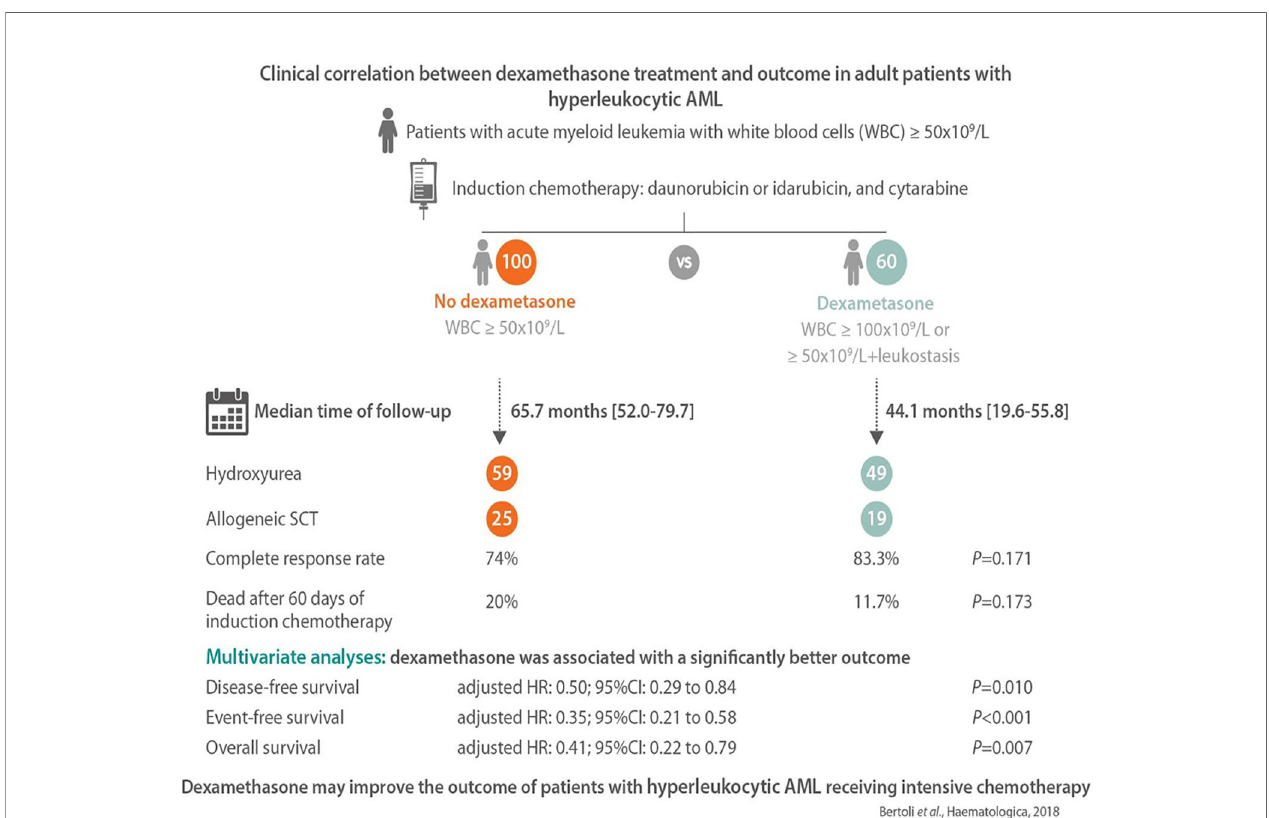
FIGURE 2 | The main results of the DEXAML-00 retrospective study in hyperleukocytic acute myeloid leukemia (AML) patients. Graphical abstract by Haematologica showing the endpoints of a retrospective, monocentric study comparing the addition of dexamethasone to standard induction chemotherapy in AML patients with hyperleukocytosis de fi ned as a white blood cell count ≥ 50 × 10 9 /L. From 2010 to 2015, 60 patients received dexamethasone (10 mg/12 h, days 1 – 3) and were compared to 100 patients who did not received dexamethasone from 2004 to 2009. In multivariate analysis, dexamethasone was associated with a signi fi cant improvement of disease-free, event-free and overall